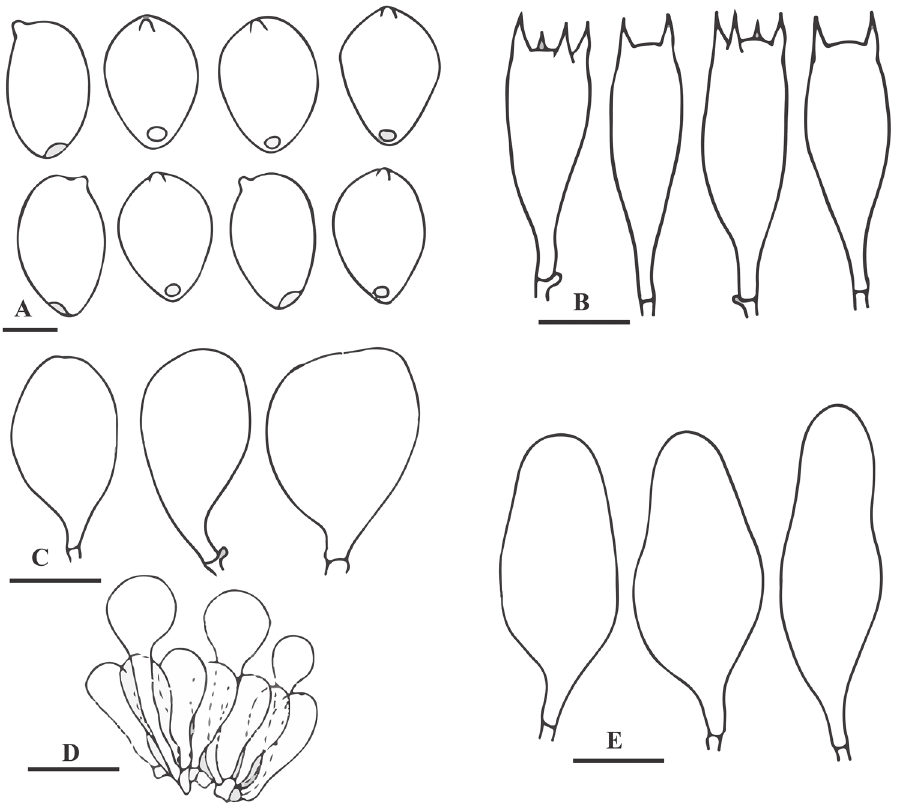
Figure 5. Anatomical features of Parasola glabra sp. nov. (LAH-SHP-5). A Basidiospres B Basidia C Pleurocystidia D Pileipellis E Cheilocystidia. Scale bars: 12 µm ( A ), 20 µm ( B–E